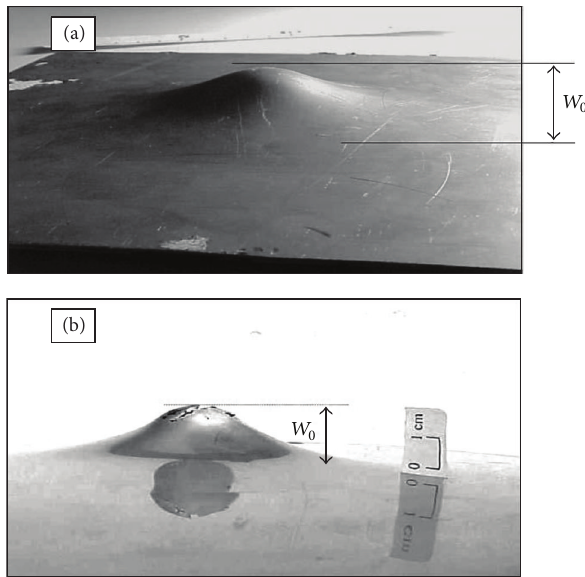
Figure 3: Shape of the metallic plate after impact.